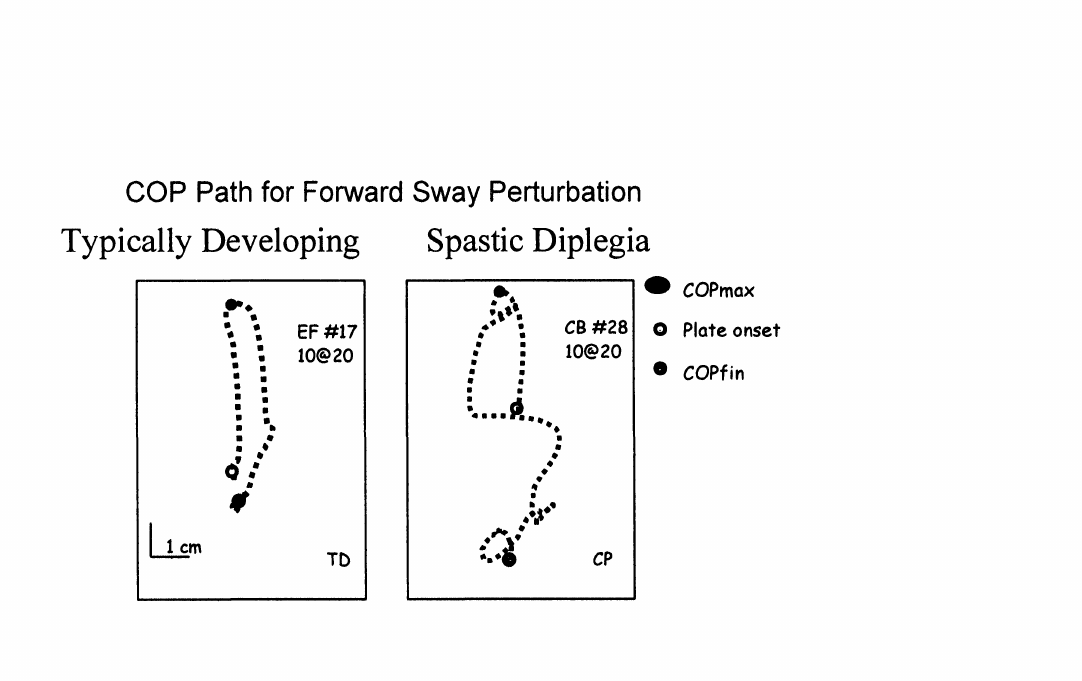
Fig. 1" Graph showing the total COP movement used to recover stability following a platform displacement causing forward sway for a typically developing child (left) and a child with spastic diplegia (right). Both children were exposed to similar types of